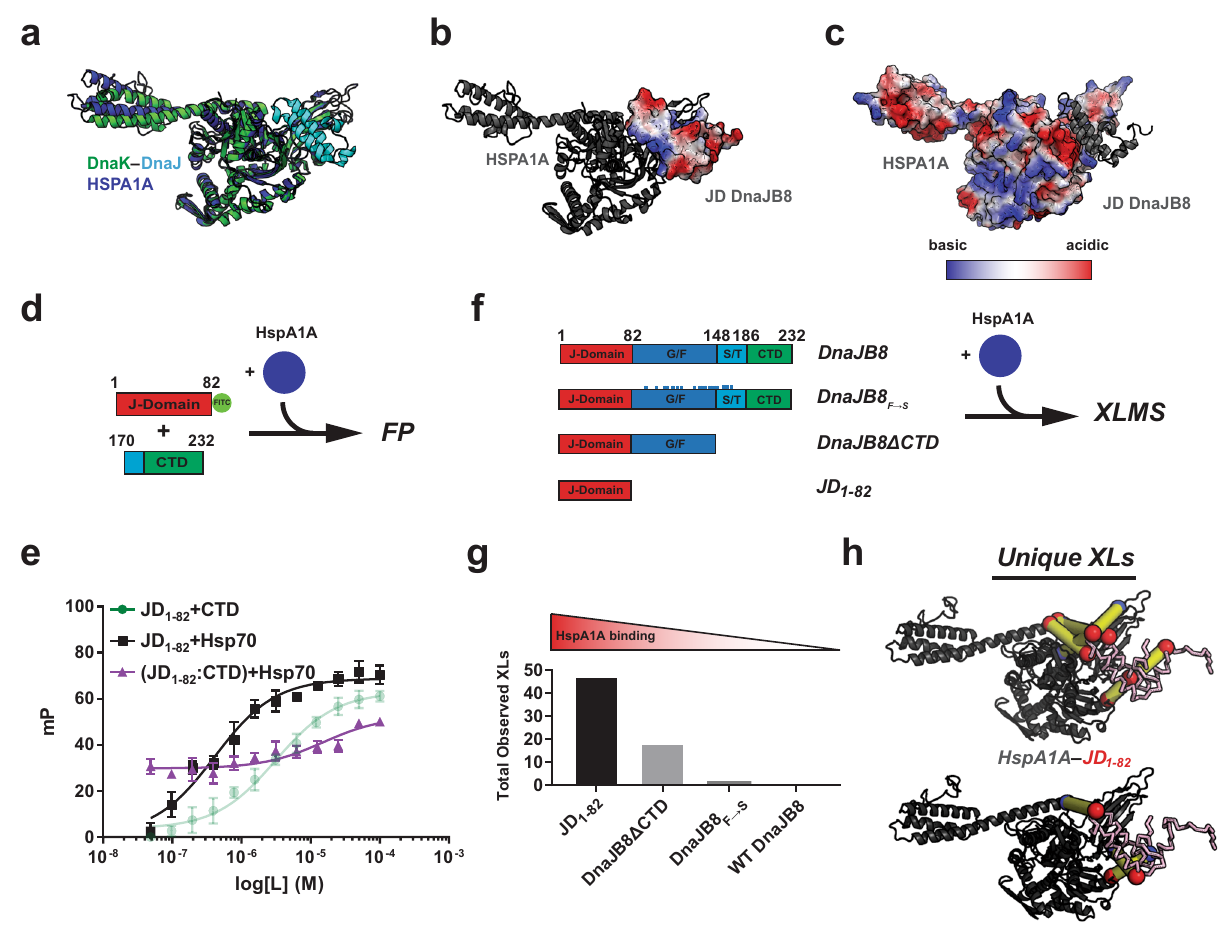
Fig. 6 CTD and HspA1A compete for the same basic binding surface on DnaJB8 JD. a Structural superposition of a representative HspA1A structural homology model (blue) with a crystal structure of DnaK – DnaJ (green and cyan, respectively; PDB ID: 5NRO) shows good agreement. b , c Electrostatic surface potential of DnaJB8 JD docked into the JD binding site on HspA1A (shown in black cartoon representation). A basic surface on helix 2 docks